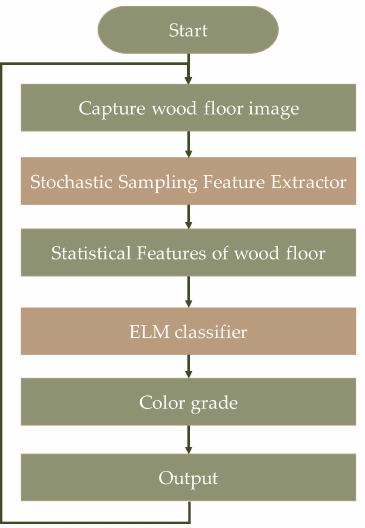
Figure 6. Flow chart of the proposed method for online classification of solid wood floors.